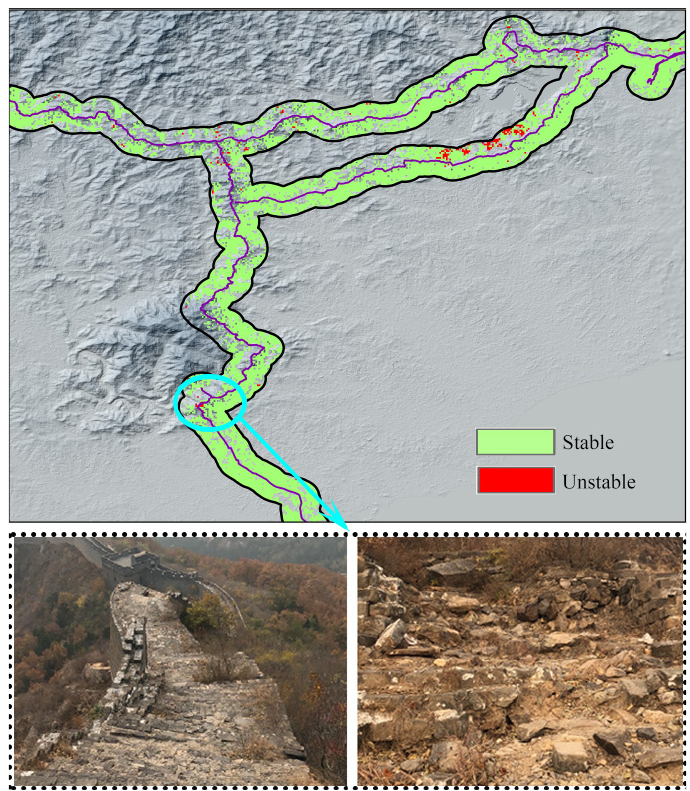
Figure 15. Thematic map of the stability of the Shanhaiguan Great Wall corridor ( top ) with two typical landscapes in the unstable area ( bottom ).